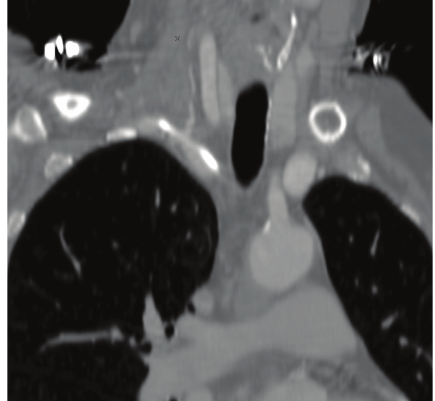
Figure 2: Oblique reformat of CT angiogram showing the entry site of the catheter into the artery and location of the origin of the vertebral artery.